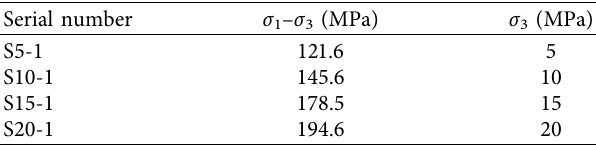
Figure 1: The rock servo-controlled rheology testing machine. Table 1: Experiment results of rock specimens under different confining